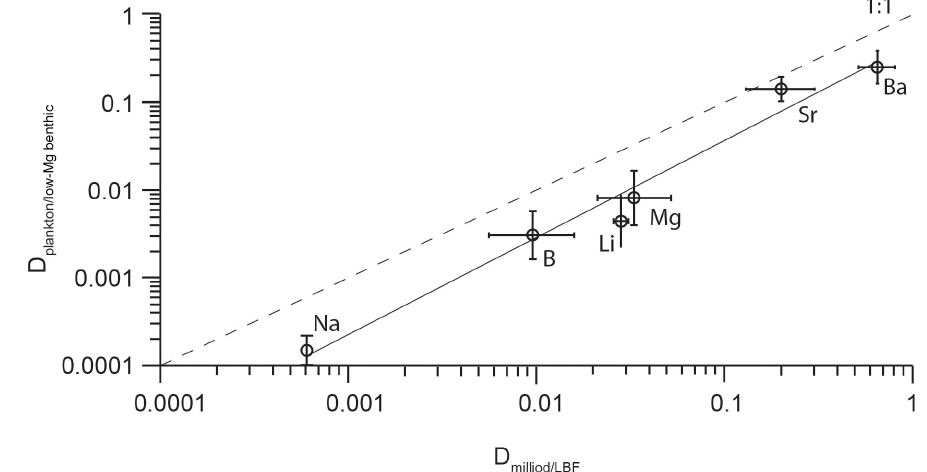
Figure 5. Partition coefficients for Li, B, Na, Mg, Sr and Ba for two groups of foraminifera (large benthic foraminifera + Miliolids and the low-Mg species). Data on which the average partition coefficients are based are listed in the Supplement. The ranges indicate the maximum range in published partition coefficients. The linear regression between the partition coefficients for these two groups is described by: D plankton/low-Mgbenthic = 0 . 3992 × D miliolid/LBF + 0 . 0081. Elemental results for Miliolid species are confined to Mg / Ca and Sr / Ca. Li / Ca ratios were taken from Delaney et al. (1985), Hall and Chan (2004a), Marriott et al. (2004), Yu et al. (2005), Ni et al. (2007), Bryan and Marchitto (2008), Hathorne et al. (2009), Dawber and Tripati (2012), and Evans et al. (2015); B / Ca ratios are from Yu et al. (2005), Yu and Elderfield (2007), Foster (2008), Hendry et al. (2009), Allen et al. (2011, 2012), Dawber and Tripati (2012), Babila et al. (2014), and Kaczmarek et al. (2015); Na / Ca ratios are from Delaney et al. (1985), Ni et al. (2007), Bian and Martin (2010), Wit et al. (2013) and Evans et al. (2015); Mg / Ca ratios are from Toyofuku et al. (2000), Raja et al. (2005), Yu et al. (2005), Elderfield et al. (2006), Segev and Erez (2006), Hendry et al. (2009), Dueñas-Bohórquez et al. (2009, 2011), Dawber and Tripati (2012), Wit et al. (2012, 2013), Babila et al. (2014), De Nooijer et al. (2014a), Sadekov et al. (2014), and Evans et al. (2015). Foraminiferal Sr / Ca ratios are taken from Raja et al. (2005), Yu et al. (2005), Hendry et al. (2009), Dueñas-Bohórquez et al. (2009, 2011), Dawber and Tripati (2012), Wit et al. (2013), De Nooijer et al. (2014a), and Evans et al. (2015). Ba / Ca ratios are from this study, Lea and Boyle (1989, 1991), Lea and Spero (1994), Hall and Chan (2004b), Ni et al. (2007), Hönisch et al. (2011), and Evans et al.